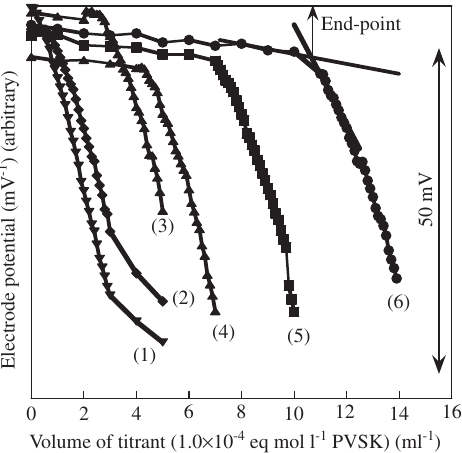
8.0 × 10 -6 m PHMB-HCl, respectively.